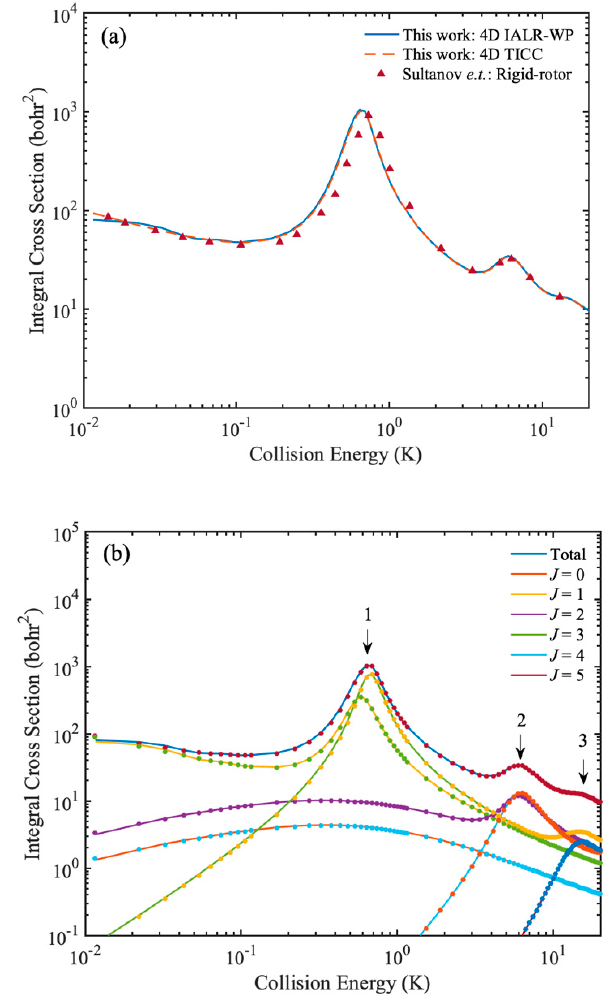
Figure 7. ( a ) Rotational quenching ICSs of HD( v = 0, j = 1) + H 2 ( v = 0, j = 0) → HD( v = 0, j = 0) + H 2 ( v = 0, j = 0) collision calculated by 4D TICC method and 4D IALR-WP method, and compared with the results calculated by Sultanov et al. by using rigid-rotor model. ( b ) J resolved rotational quenching ICSs of HD( v = 0, j = 1) + H 2 ( v = 0, j = 0) → HD( v = 0, j = 0) + H 2 ( v = 0, j = 0) collision. The solid and dot lines are obtained by IALR-WP method and TICC method,